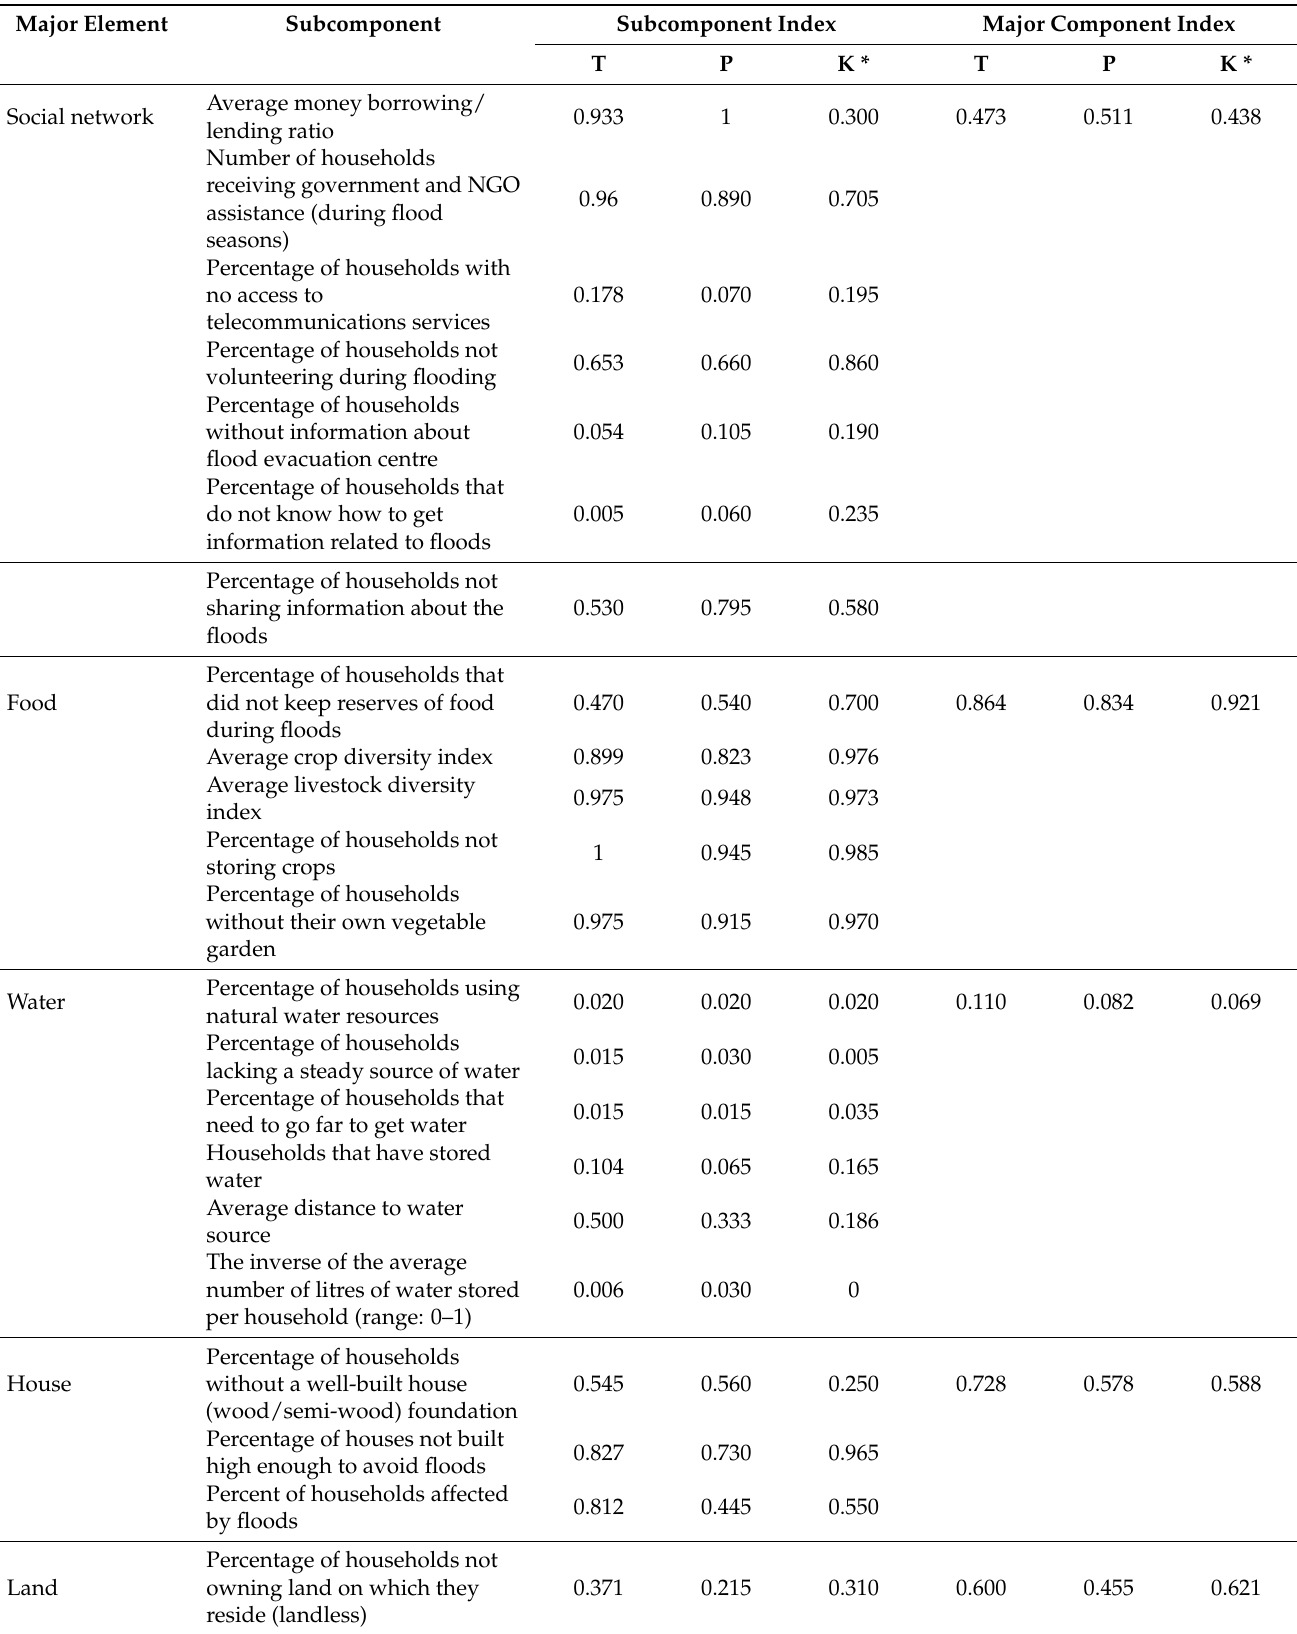
Table 7. Indexed subcomponents, main components, and total LVI for the Districts of Temerloh, Pekan and Kuantan. Major